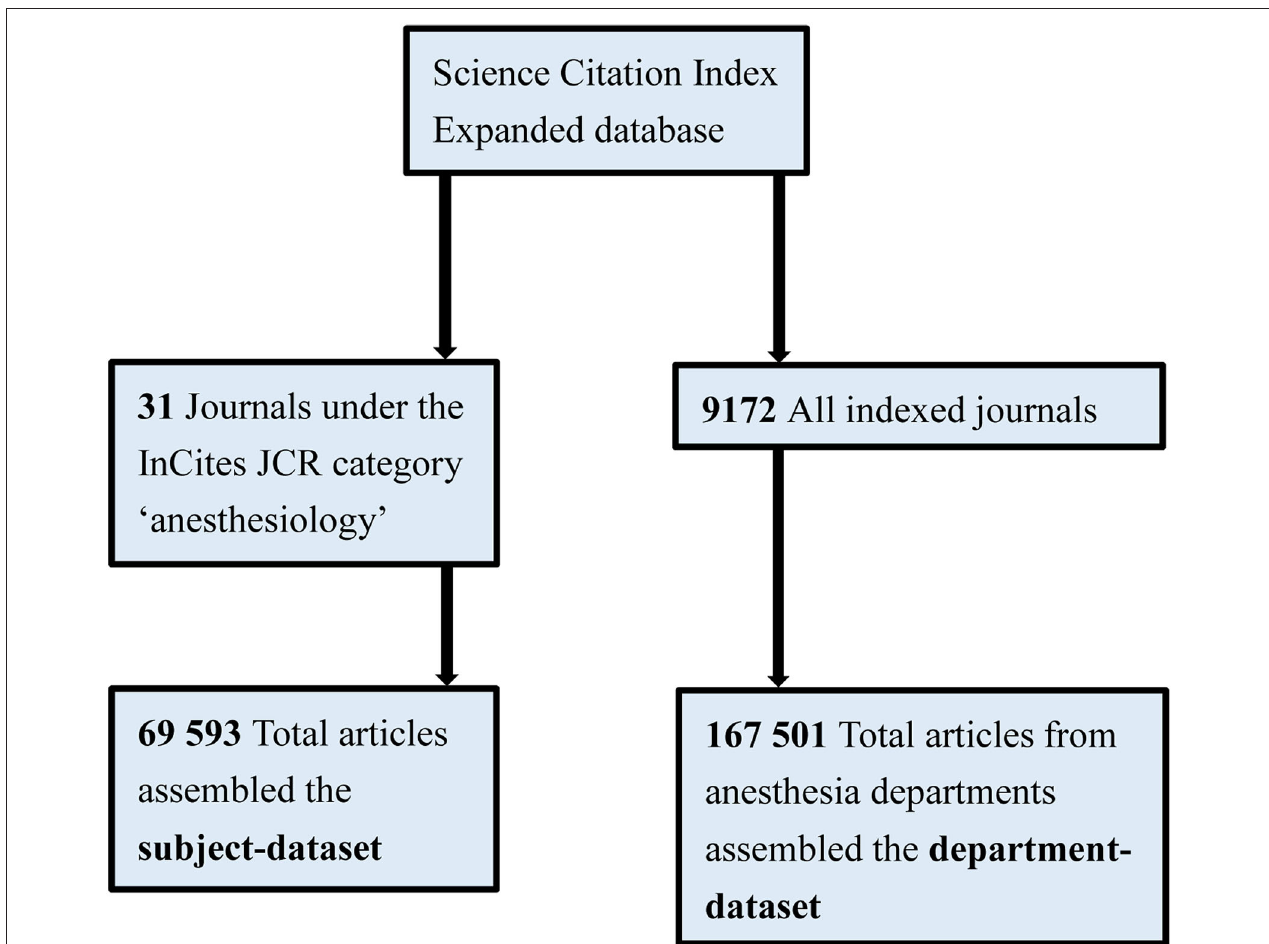
FIGURE 1 | Study flow